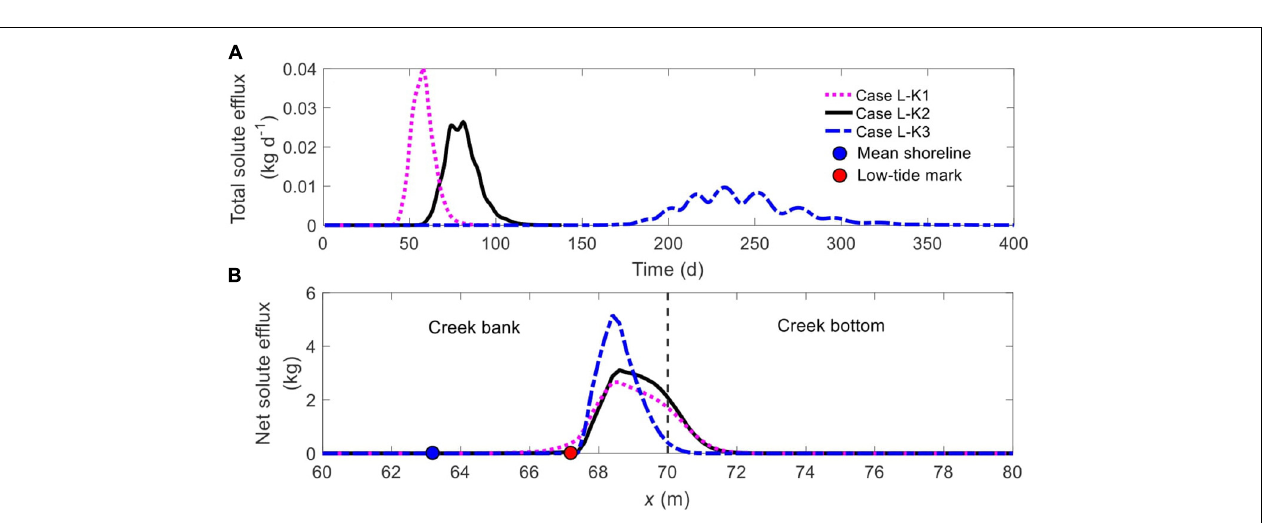
FIGURE 7 | Comparison of (A) time-dependent total solute efflux and (B) spatial distribution of net solute efflux across the SWI (BCDE in Figure 1 ) for different ratios of K mud / K sand . The blue and red nodes in panel (B) represent the mean shoreline and low-tide mark, respectively, while the vertical dashed line separates creek bank (left) and creek bottom